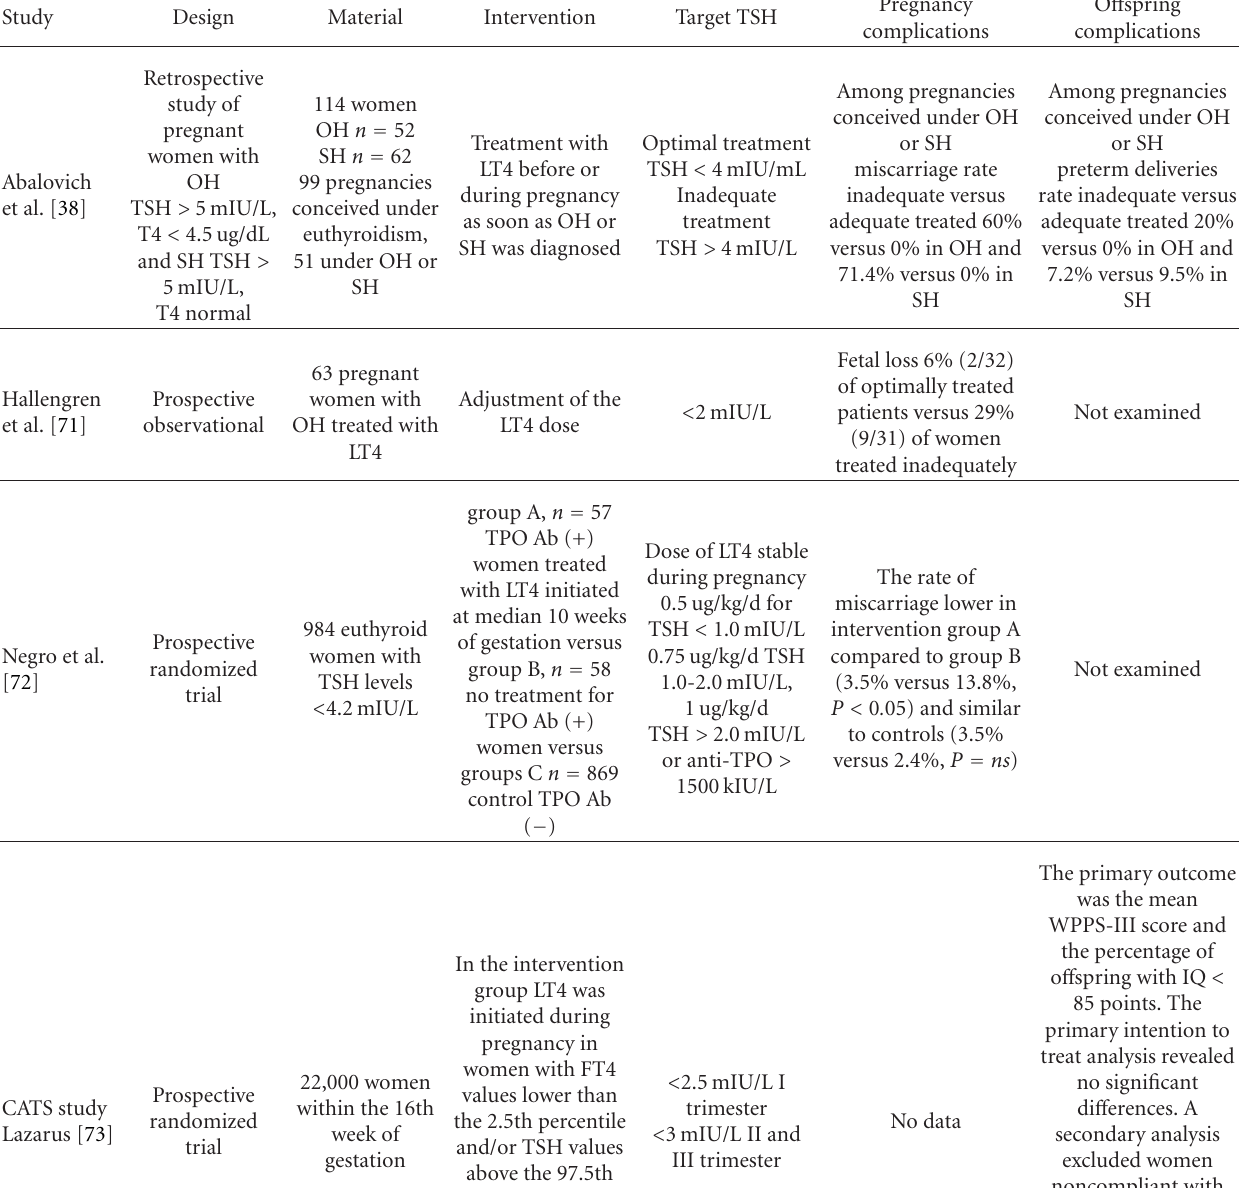
Table 1: Intervention studies describing the e ffi cacy of LT4 treatment during